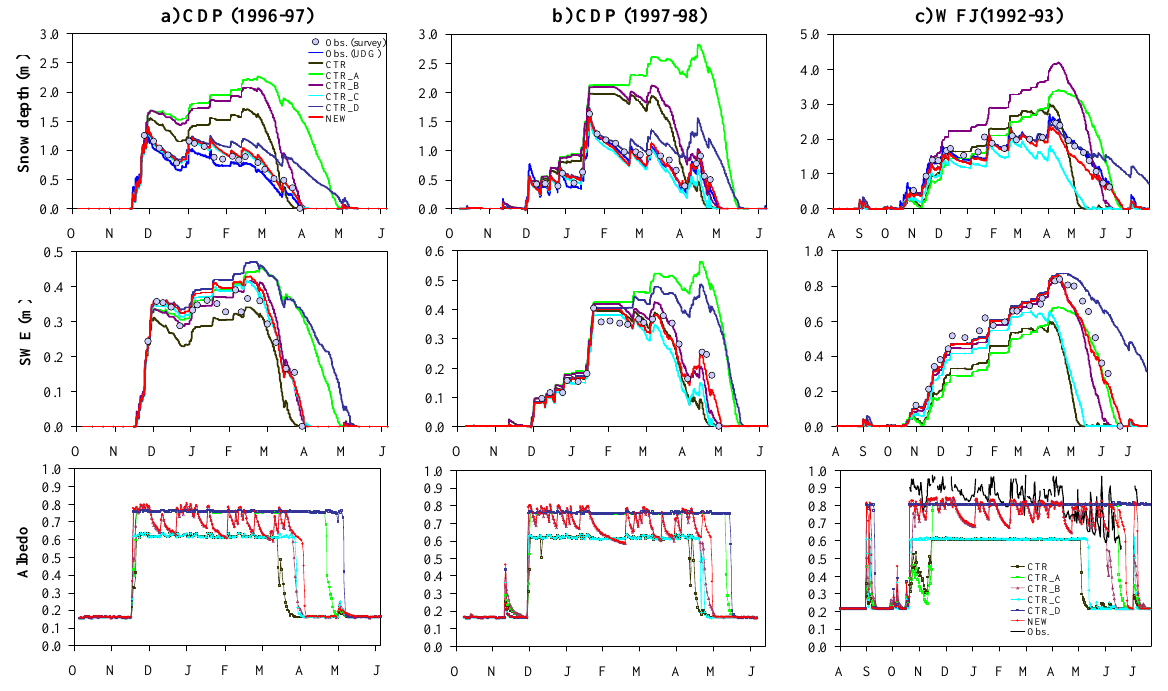
Fig. 7. Comparison of observed and simulated snow depth, SWE and albedo at (a) CDP (1996–1997), (b) CDP (1997–1998) and (c) WFJ (1992–1993) for different sets of simulations as shown in Table 5.